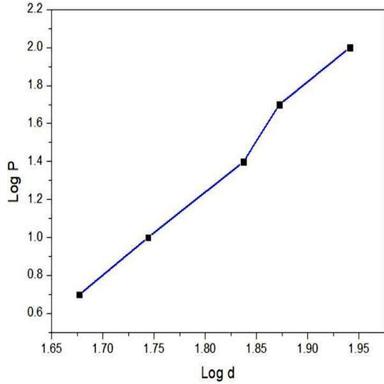
Variation of log P with log d to determine Meyer's index – Title crystal.